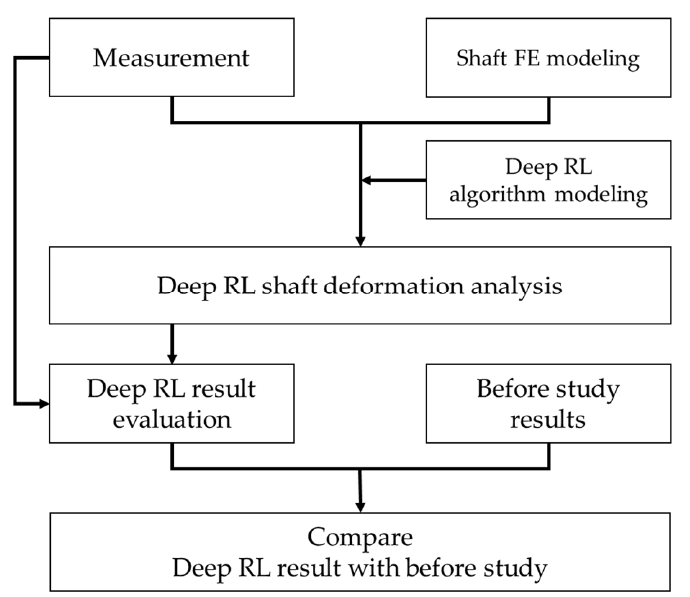
Figure 1. Outline of study.